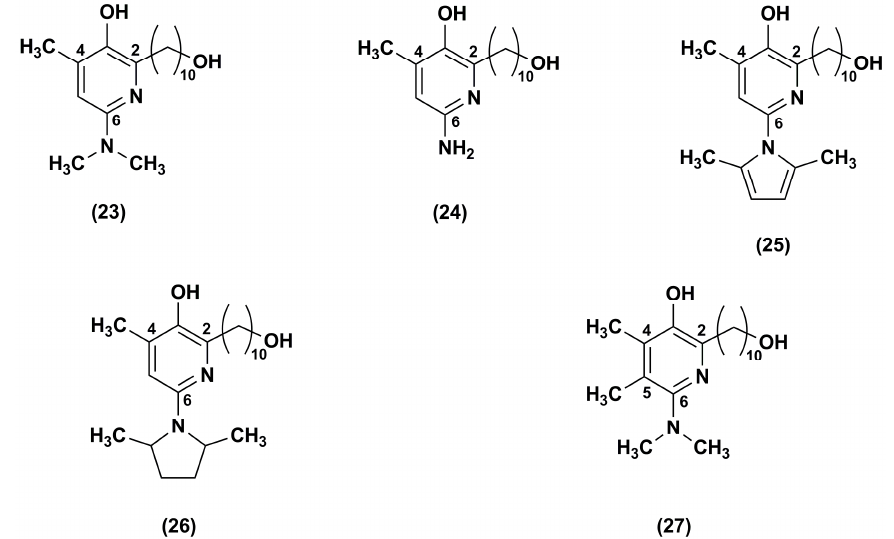
Figure 5. Chemical structures of IDE analogues with pyridinol core.